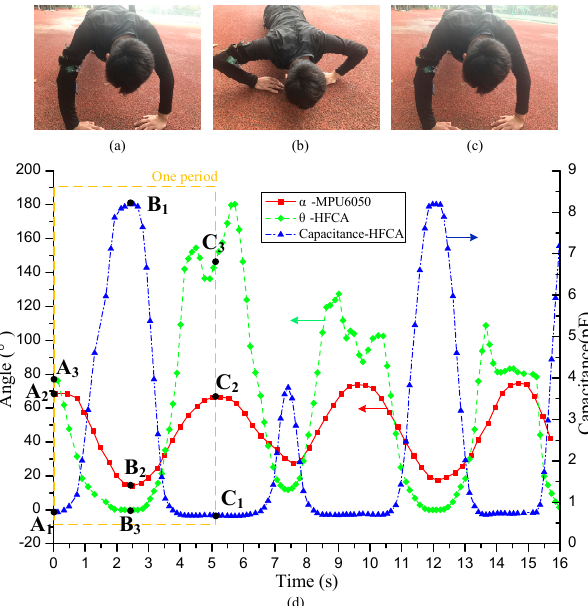
Figure 10. Push-ups experimental results. ( a ) The preparation; ( b ) The descending status; ( c ) The pushing status; ( d ) Experimental results.